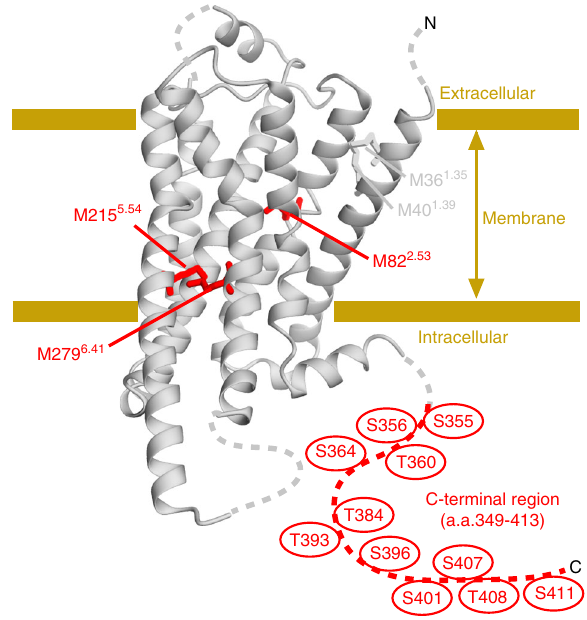
Fig. 1 Distribution of the NMR probes on the structure of β 2 AR. The crystal structure of β 2 AR (PDB ID: 3SN6) is shown as a ribbon model. The N- terminal region, intracellular loop 3, and the C-terminal region, which are either substituted with T4 lysozyme, not observed, or truncated, are shown with dotted lines. The methionine residues observed for the analysis of the conformation of the TM region are shown as sticks. M82 2.53 , M215 5.54 , and M279 6.41 , with resonances that reportedly exhibit remarkable chemical shift change upon activation, are shown as red sticks. The C-terminal region, which was segmentally labeled for the NMR observation, is shown by a red dotted line. The putative phosphorylated residues in the C-terminal region are shown. The structural model was prepared with Cuemol